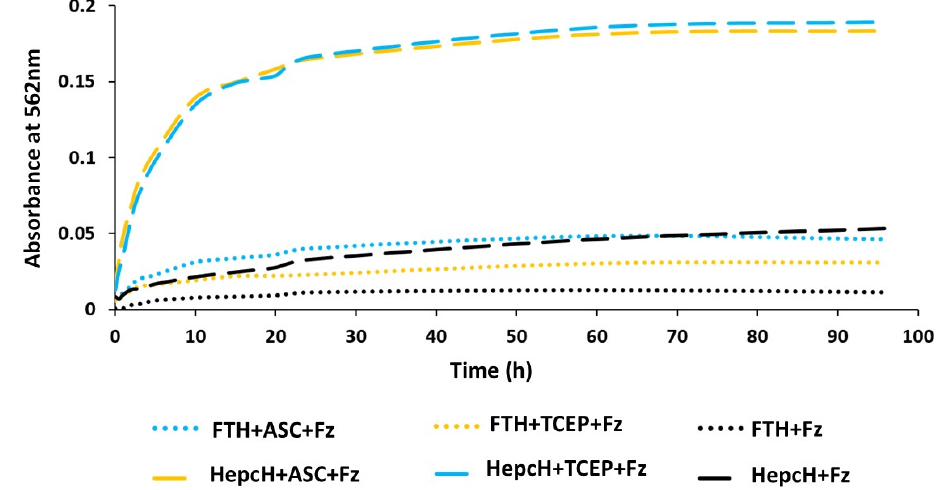
Figure 1. Iron release from HepcH subunit. This latter was incubated with the ascorbic acid (hepcH + ASC + Fz) and TCEP (hepcH + TCEP + Fz) reluctants or without (hepcH + Fz) in presence of ferrozine, which readily chelates iron with the formation of the Fe (II)-ferrozine complex that absorbs at 562 nm. Time course of iron release was performed till 96 h and a plateau was shown after 24 h of reaction. The recombinant human FTH was introduces in the analysis, as control. Results are presented as the mean of two independent experiments. Table 1. Iron concentration of HepcH and FTH monomers after treatment with ascorbic acid and TCEP.